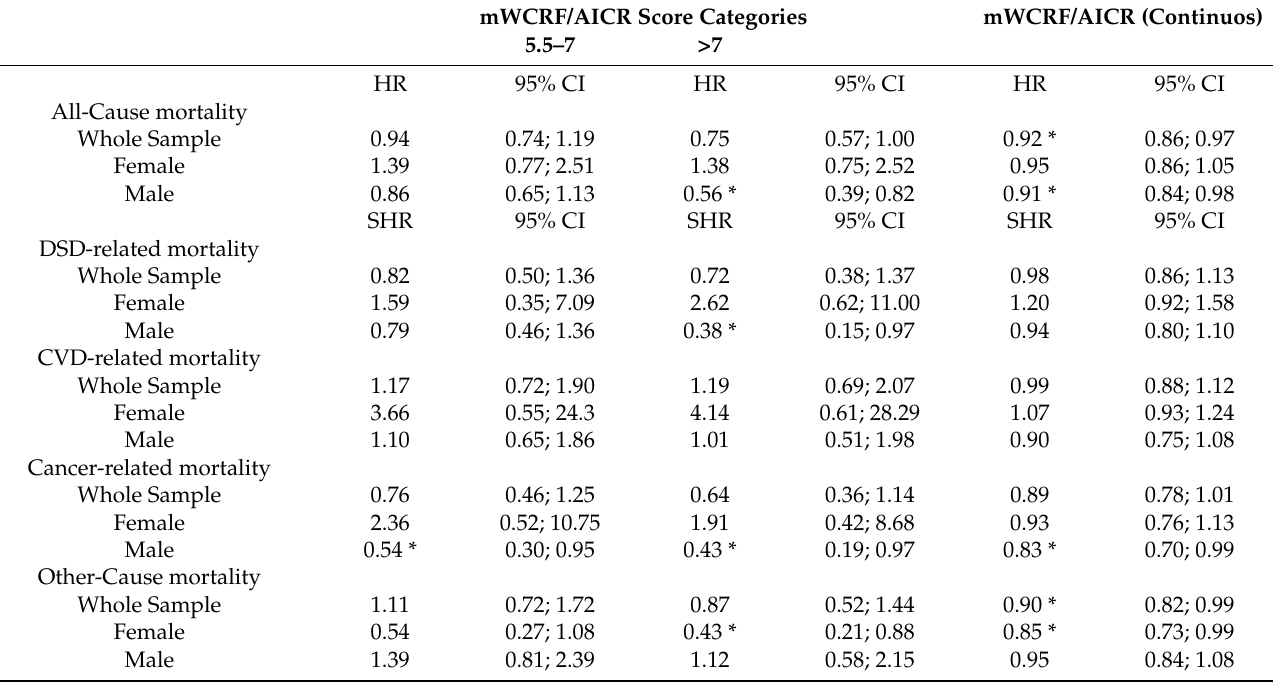
Table 3. Hazard Ratio (HR) and 95% Confidence Intervals (95% CI) for all-cause mortality and Subdistribution Hazard Ratio (SHR) and 95% Confidence Intervals (95% CI) for DSD-related mortality, CVD-related mortality, CR-related mortality and other-cause mortality from modified